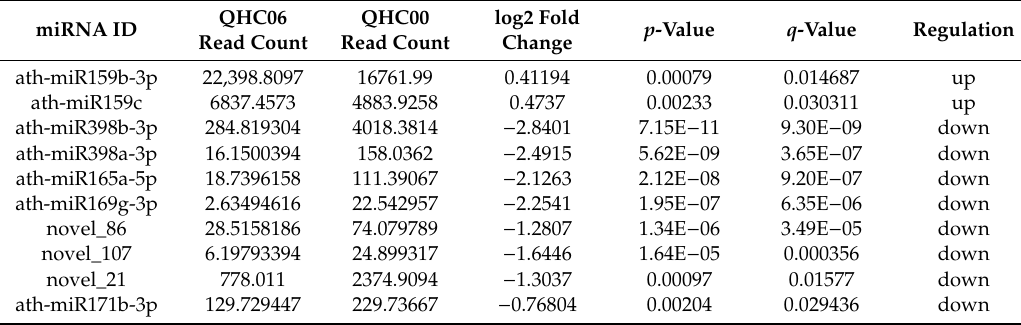
Table 2. The detailed information of DE miRNAs.